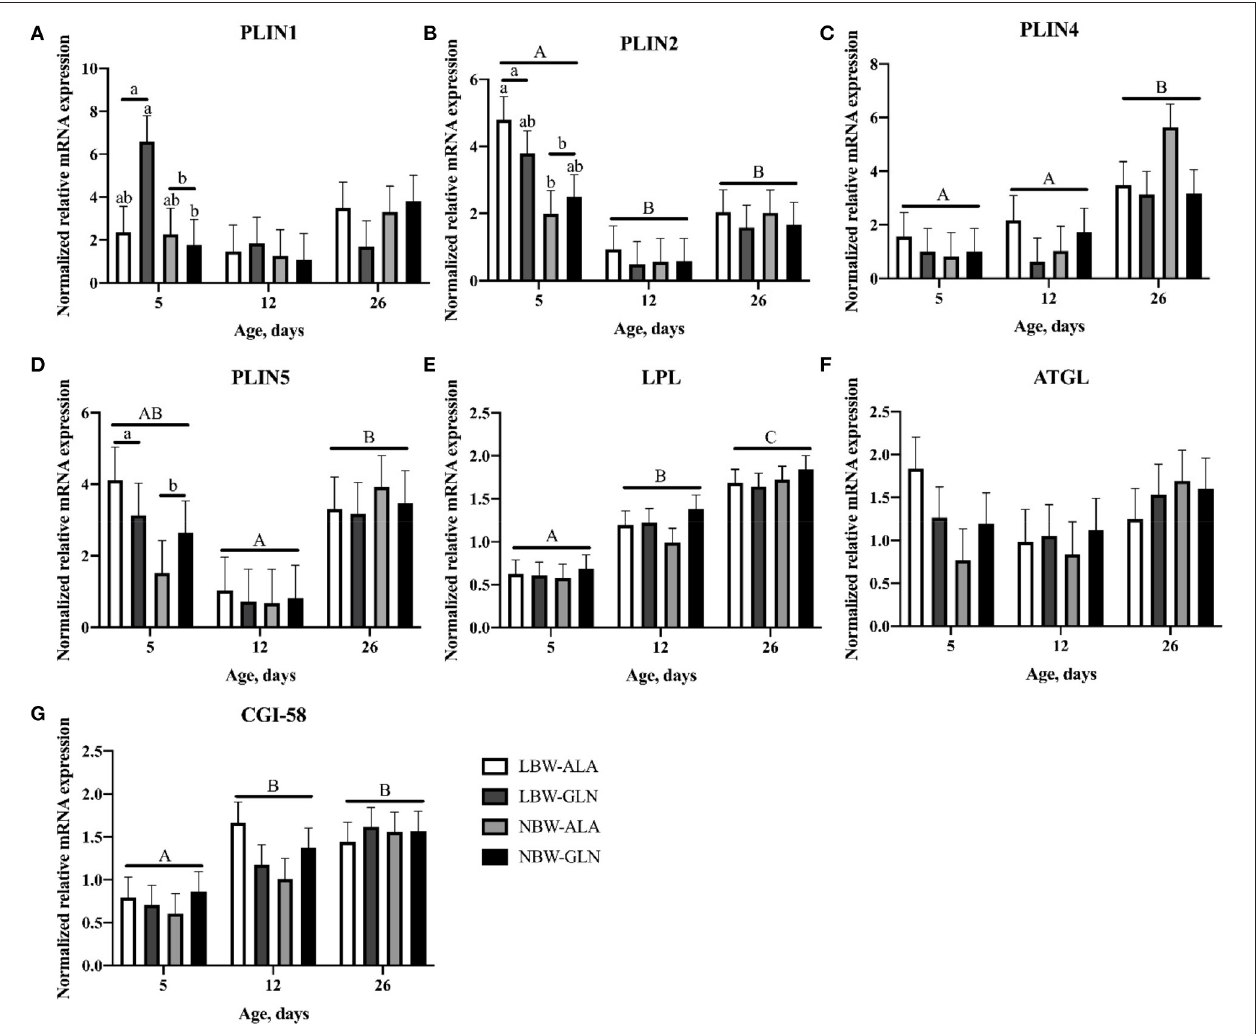
FIGURE 2 | Normalized relative mRNA expression of perilipins and related lipases in M. longissimus of low- (LBW) and normal-birth-weight (NBW) piglets at 5, 12, and 26 dpn, supplemented with glutamine (GLN) or alanine (ALA) ( n = 12 per group). Values represent LSmeans and SE in error bars of PLIN1 (A) , PLIN2 (B) , PLIN4 (C) , PLIN5 (D) , LPL (E) , ATGL (F) , and CGI-58 (G) mRNA abundance, normalized to YWHAZ and PPIA. a,b Significant differences between LBW and NBW piglets at the same age; A − C Significant differences among ages ( p < 0.05, Tukey–Kramer